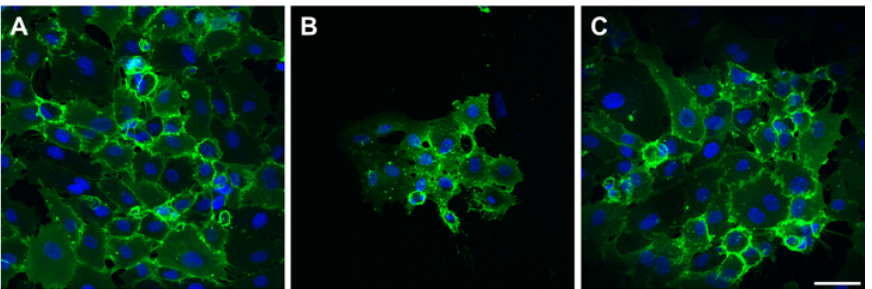
Fig 8. Confocal micrographs of HUVEC grown on polystyrene and on representative unmodified and modified P(DLLA-co-GA). Stained with anti CD-31 (green). (A) HUVEC grown on polystyrene, (B) HUVEC grown on unmodified P(DLLA-co-GA), (C) staining patterns of HUVEC, grown on NH 3 -plasma modified P (DLLA-co-GA) are comparable to those in control (A). The blue staining (Hoechst-staining) indicates cell nuclei. Scale bar = 50 μ m.